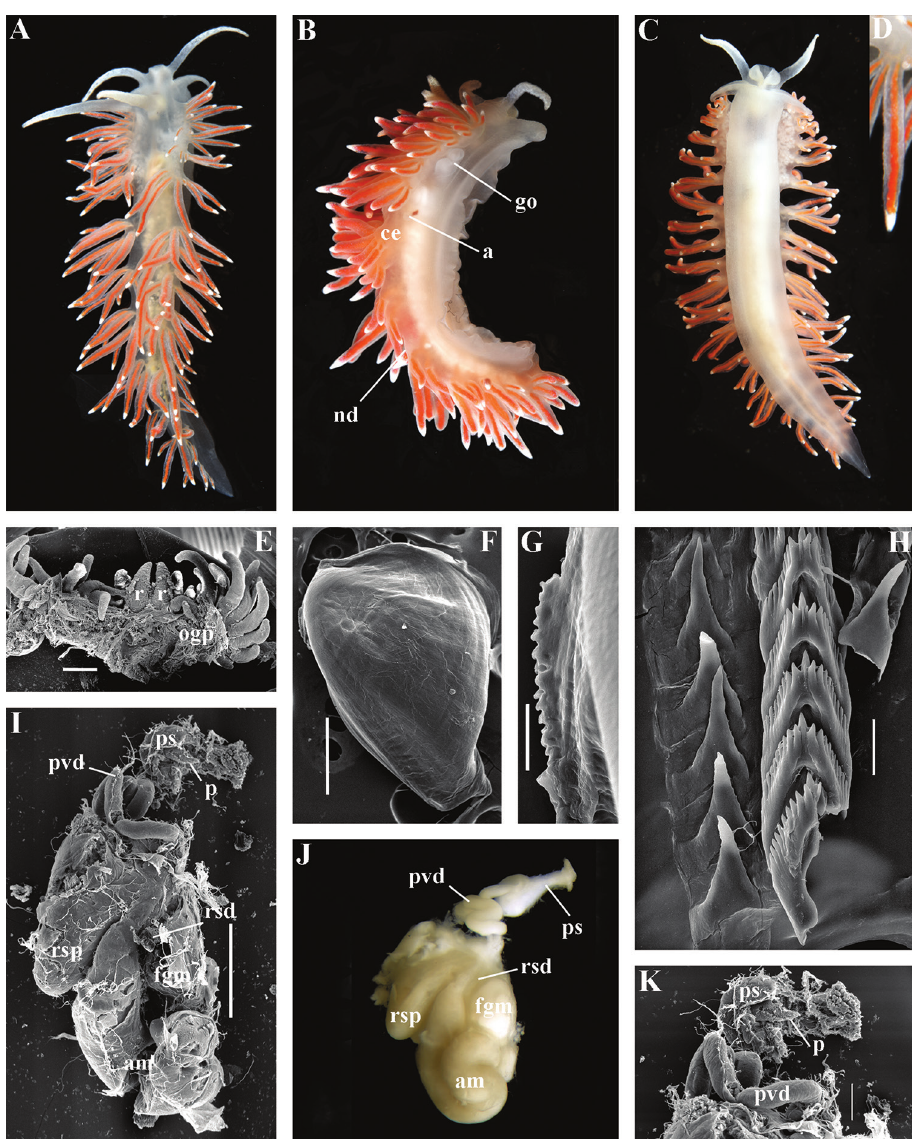
Figure 36. Carronella pellucida (Alder & Hancock, 1843), comb. n. Norwegian Sea, Gulen Dive Center. ZMMU Op-513, living specimen 18.5 mm in length: A dorsal view B lateral view C ventral view D details of cerata E dissected anterior part (pharynx removed) and rhinophores, SEM F jaw SEM G details of masti- catory process of jaw, SEM H radular teeth, posterior part, SEM I reproductive system, SEM J reproductive system, light microscopy K dissected penial sheath and penis, SEM. Abbreviations: a anus am ampulla ce ceratal elevations fgm female gland mass go genital opening nd discontinuous notal edge ogp oral gland penetrating into basis of cerata r rhinophores p penis ps penial sheath pvd prostatic vas deferens rsd distal receptaculum seminis rsp proximal receptaculum seminis. Scale bars: E = 1 mm; F, K = 300 μm; G = 30 μm; H = 30 μm; I = 1 mm. Photos and SEM images by T.A. Korshunova, A.V.